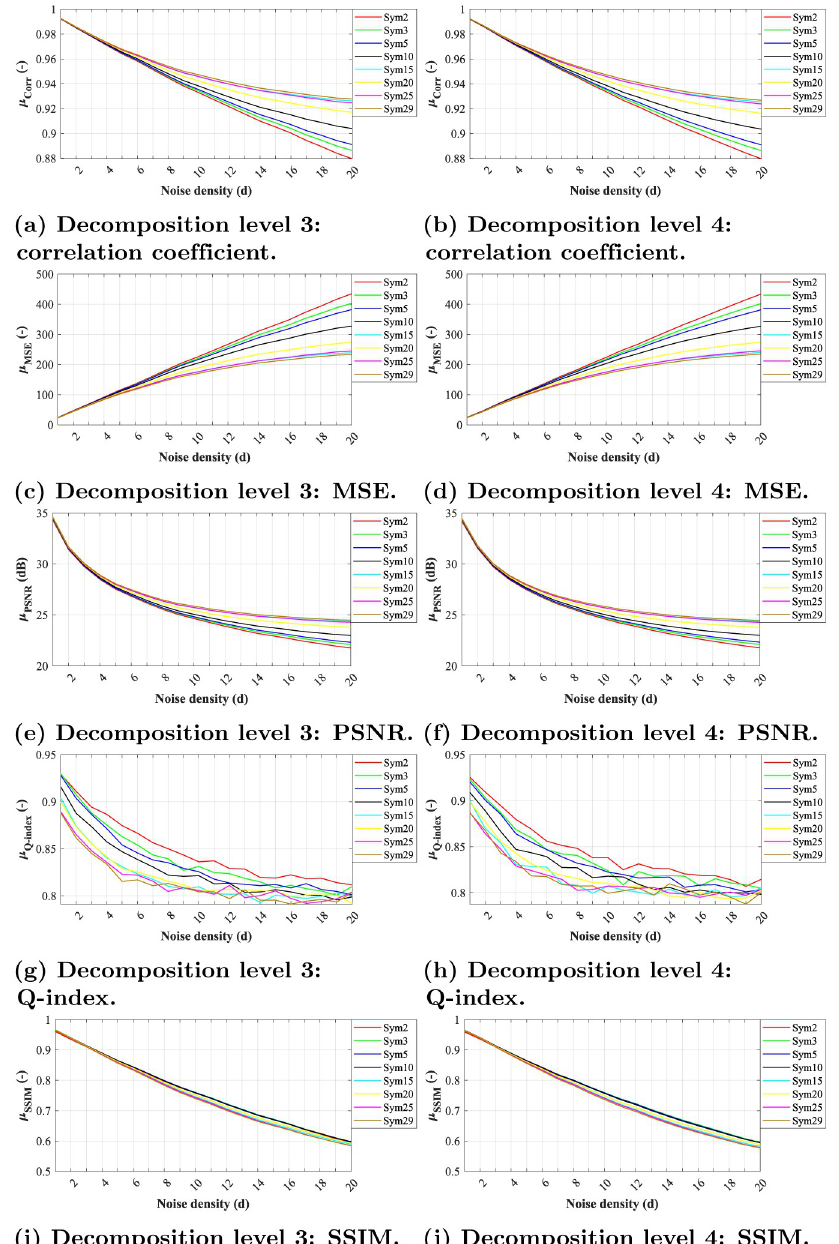
Fig 8. A comparative analysis of Salt and Pepper noise ( d = {0.001, 0.002, ... , 0.02}) for Symlets wavelets with decomposition level 3 and 4. (a) Decomposition level 3: correlation coefficient. (b) Decomposition level 4: correlation coefficient. (c) Decomposition level 3: MSE. (d) Decomposition level 4: MSE. (e) Decomposition level 3: PSNR. (f) Decomposition level 4: PSNR. (g) Decomposition level 3: Q-index. (h) Decomposition level 4: Q-index. (i) Decomposition level 3: SSIM. (j) Decomposition level 4: